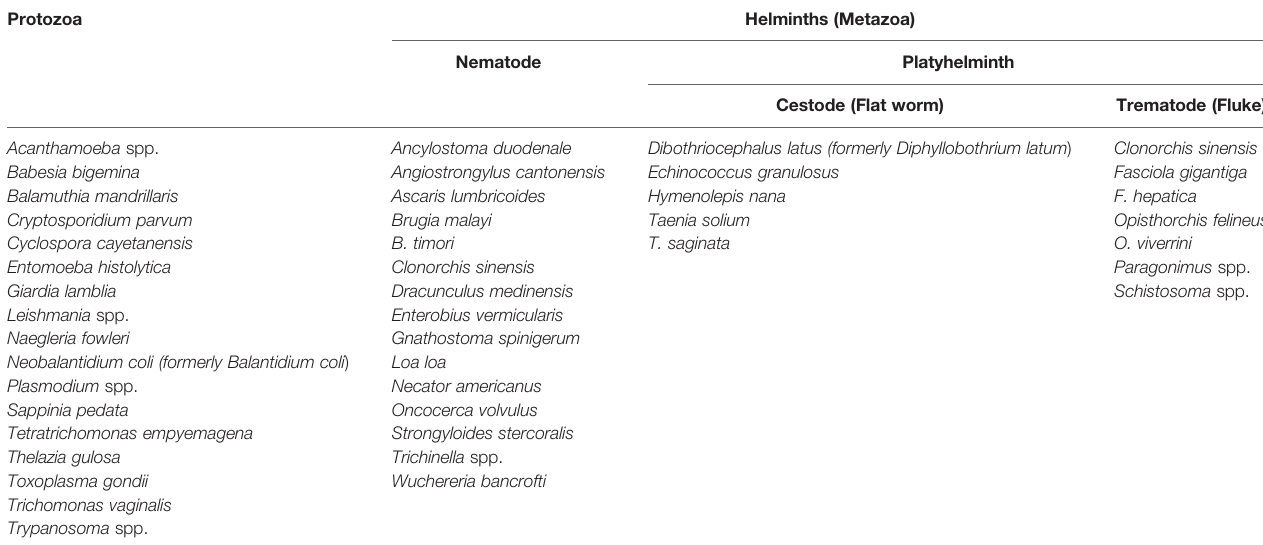
TABLE 1 | Examples of protozoa and helminths that cause diseases in humans.